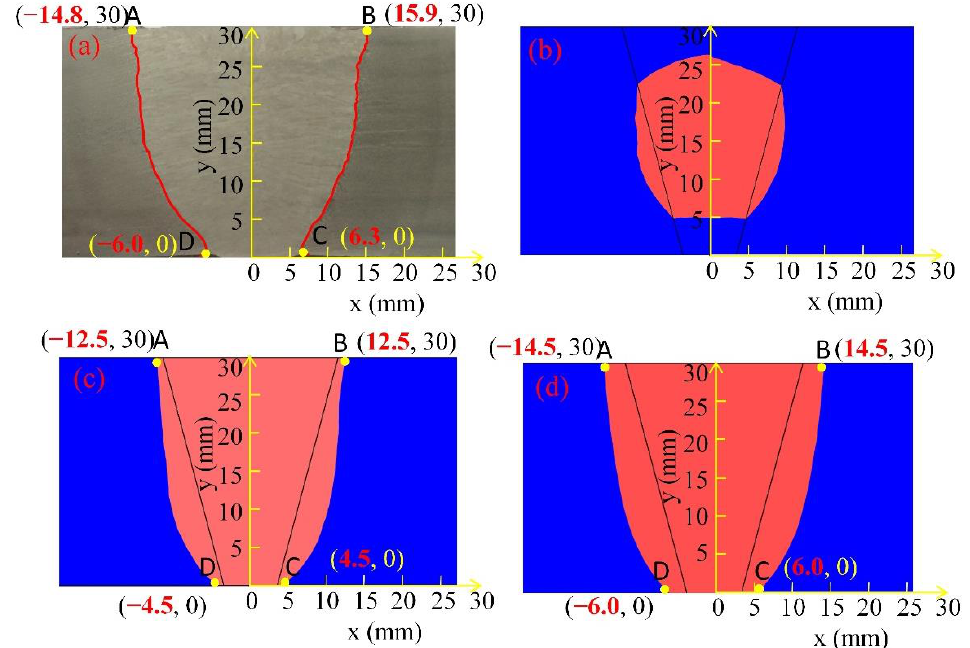
Figure 9. Melt pool and fusion line of experiments and simulated welded joints of 30 mm thickness steel plates, ( a ) experimental weld joint, ( b ) modelling using linear path heat source, ( c ) modelling using sinusoidal path heat source, ( d ) modelling using oscillate-stop path heat source. Table 7. Comparison of coordinates of selected points between simulated and experimental welding melt